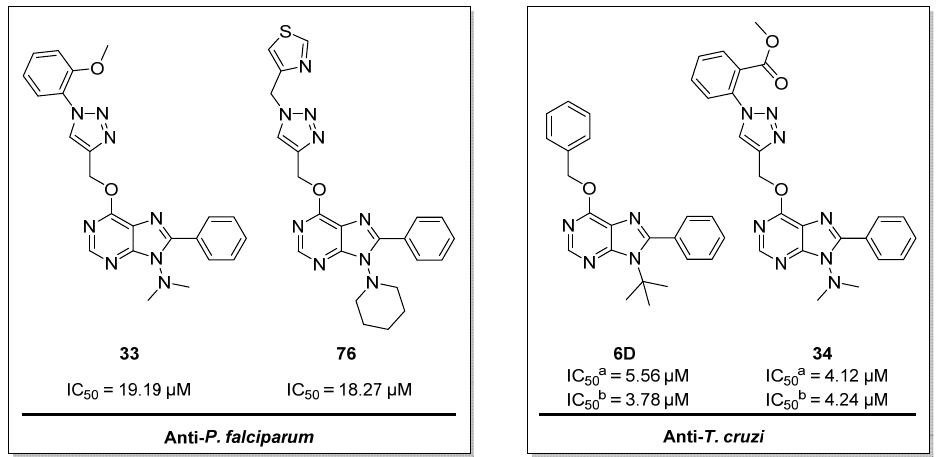
Figure 9. Chemical structures of the lead compounds against P. falciparum and T. cruzi . a : anti- T. cruzi primary assay; b : antiamastigote assay.